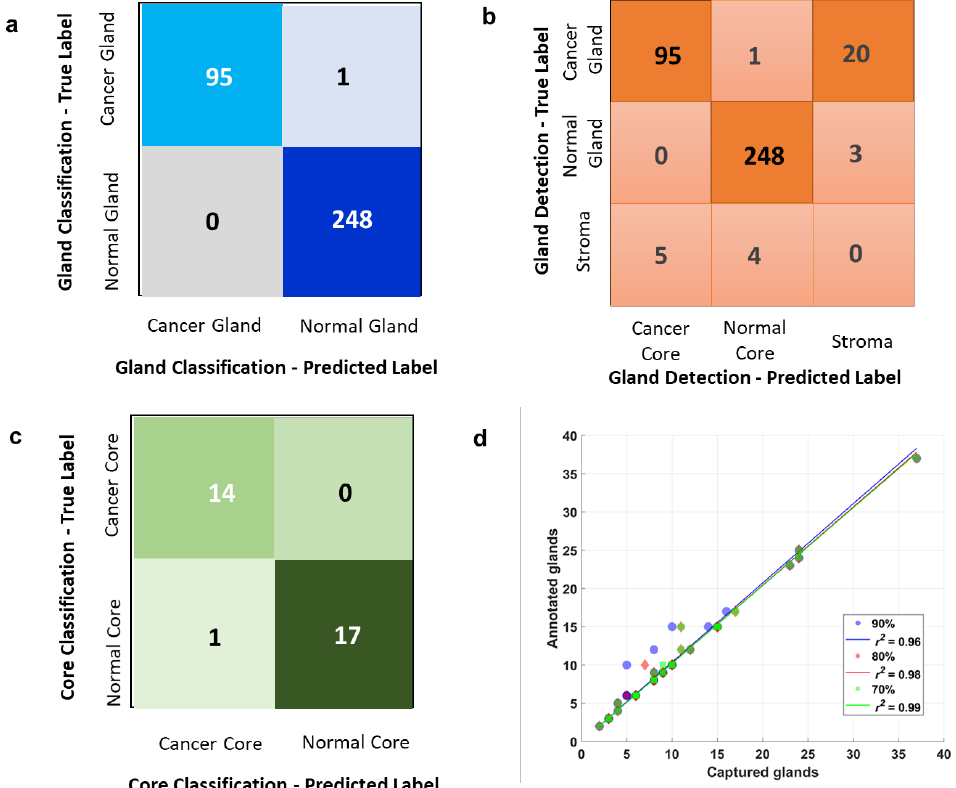
Figure 5. The performance of classification, detection, and diagnosis on a test dataset. ( a ) A confusion matrix which shows